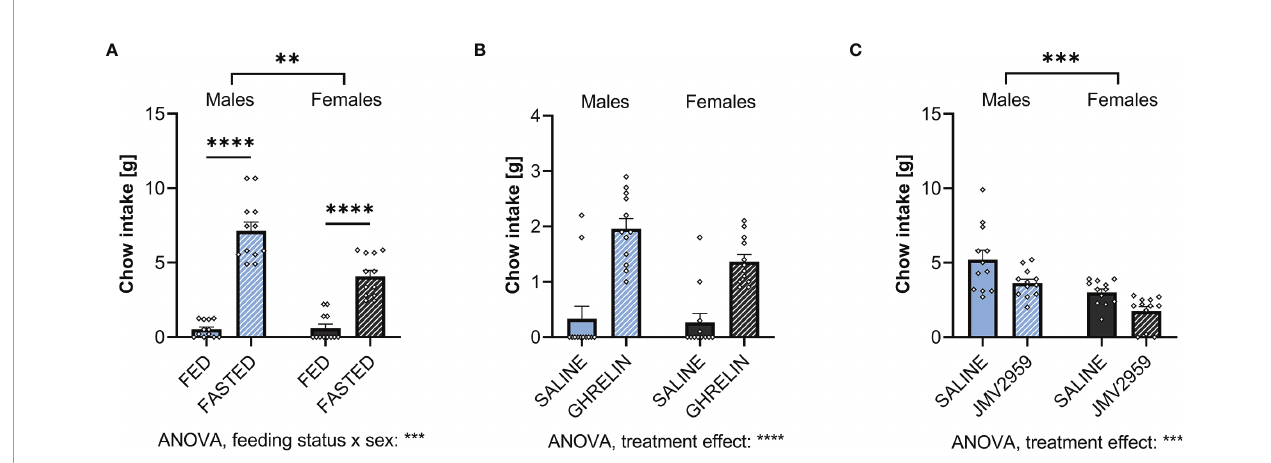
FIGURE 3 | Ghrelin and overnight fasting increases and blockage of ghrelin signaling decreases food intake in both sexes. When fasting male and female rats overnight, both sexes consume more chow within 1h when compared to ad libitum fed controls (A) . Treating ad libitum fed males and females with ghrelin increased 1h chow intake (B) . Blocking fasting-induced ghrelin signaling in overnight fasted rats with JMV2959 decreased 1h chow intake (C) . All data are presented as mean ± SEM. ** p < 0.01, *** p < 0.001, **** p < 0.0001 compared with respective controls. n = 12 per treatment group in each